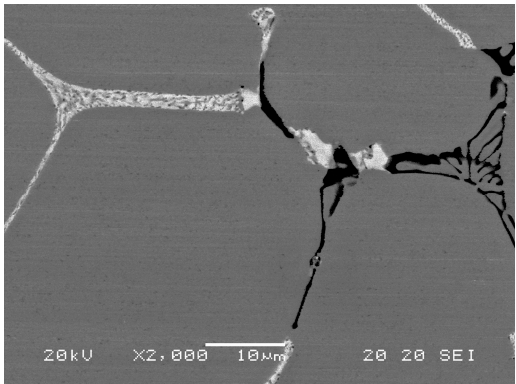
Figure 4. Microstructure of the material after continuous casting, obtained by scanning electron microscopy. Gray phase: solid solution (Al); White phase: Cu 2 Al; Black phase: Mg 2 Si.